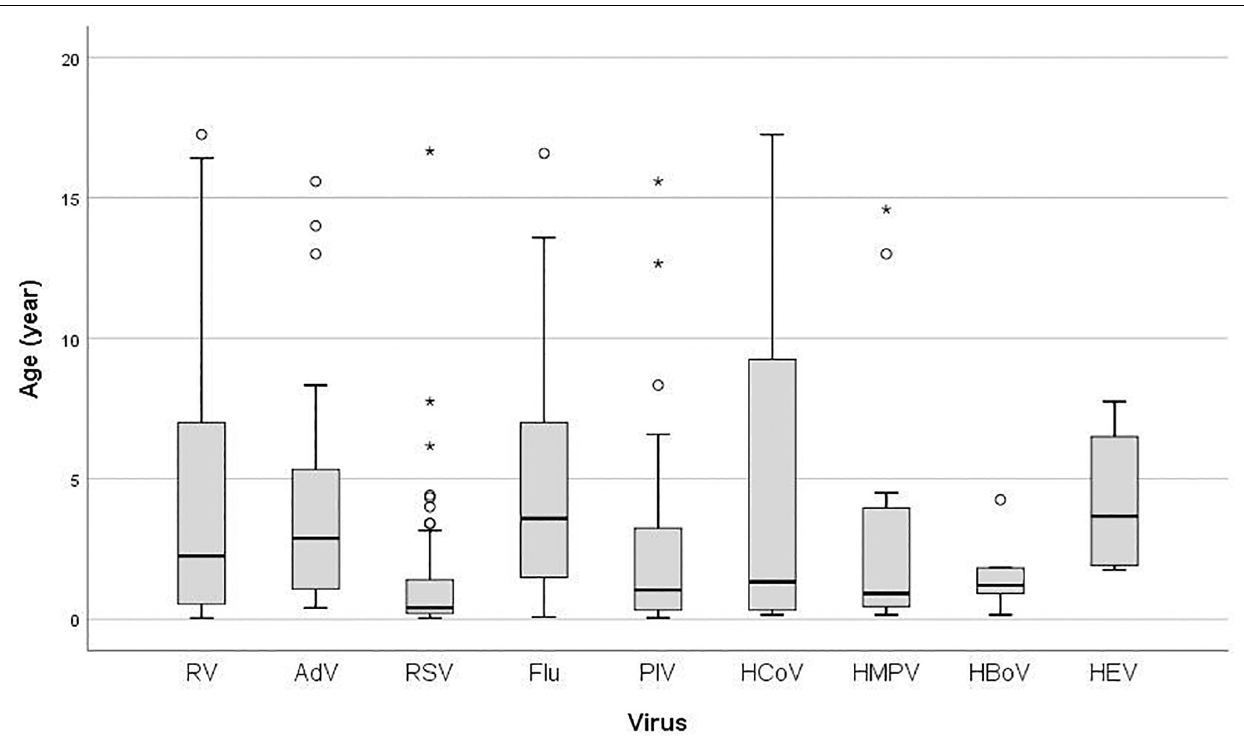
FIGURE 1 | Box plot of patient’s age infected with: RV, rhinovirus; AdV, adenovirus; RSV, respiratory syncytial virus; Flu, Influenza virus type A and B; PIV, parainfluenza virus type 1–4; HCoV, coronavirus 229E/NL63 and OC43; HMPV, human metapneumovirus; HBoV, human bocavirus; HEV, human enterovirus; the ends of the box are the upper and lower quartiles, the median is marked by a vertical line inside the box and the ends of the whiskers represent the minimum and maximum of all of the data; data not included between the whiskers are plotted as an outlier with a dot.